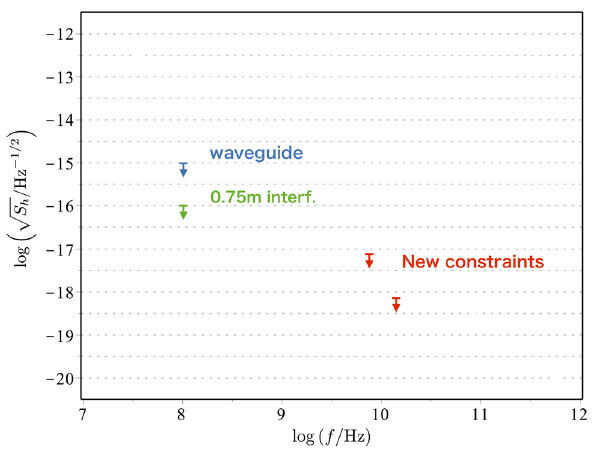
Fig. 1 Several experimental sensitivities and constraints on high fre- quency gravitational waves are depicted. The blue color represents an upper limit on stochastic gravitational waves by waveguide experiment using an interaction between electromagnetic fields and gravitational waves [20]. The green one is the upper limit on stochastic gravitational waves, obtained by the 0.75 m interferometer [19]. Our new constraints on continuous gravitational waves are plotted with a red color, which also represent the sensitivity of the magnon gravitational wave detector for stochastic gravitational